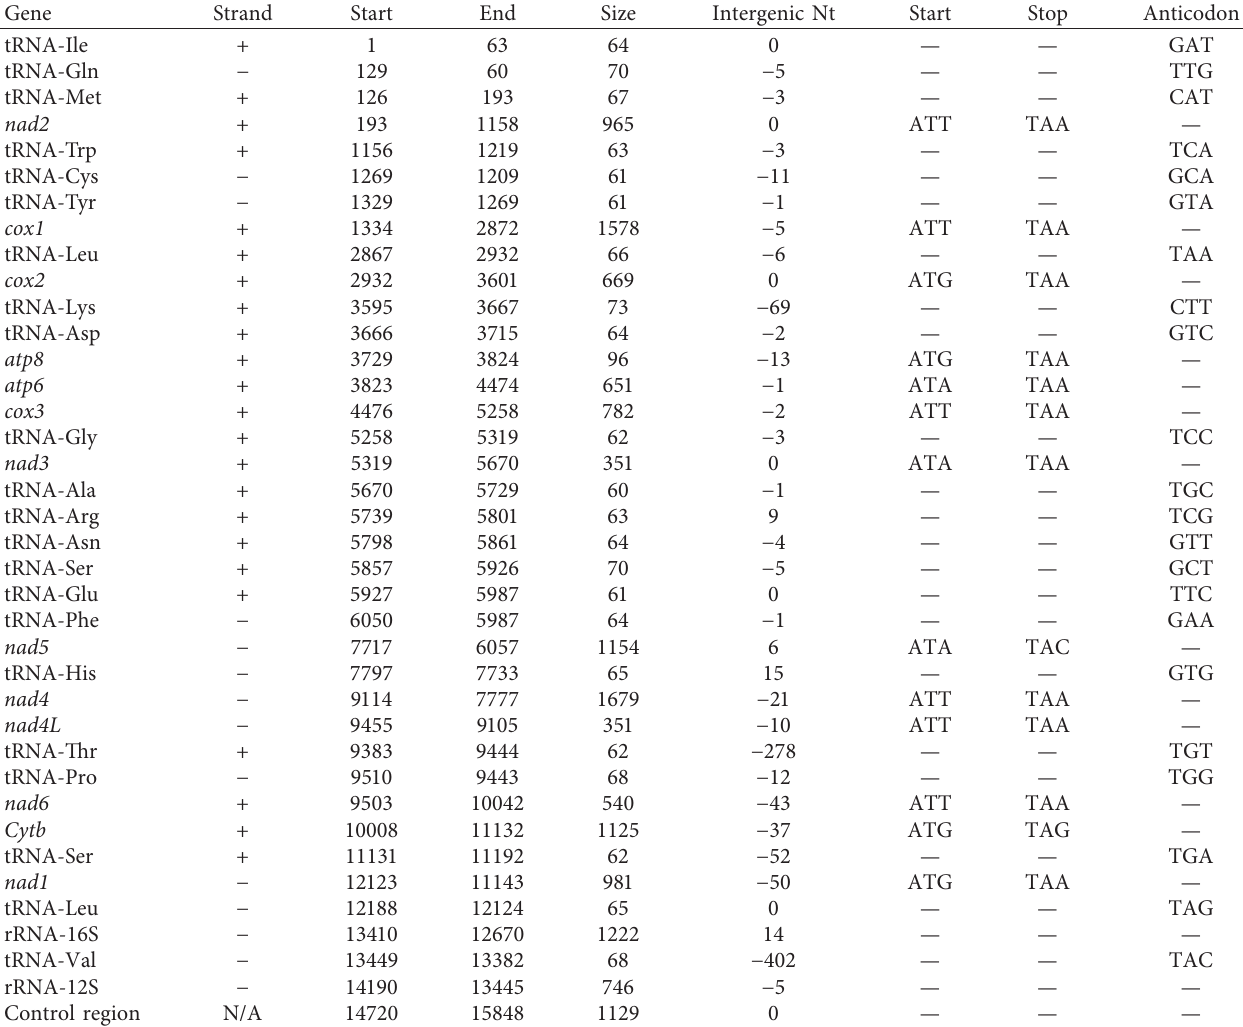
Table 2: Annotation of the mitochondrial genome of Haplaxius crudus